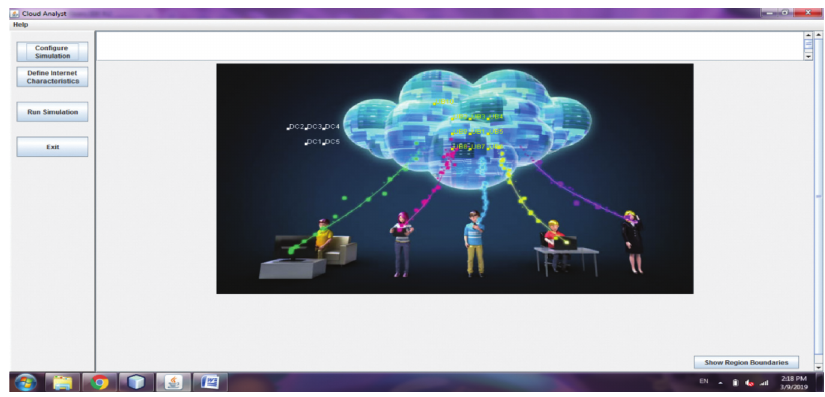
Figure 7: Simulation Started Window.